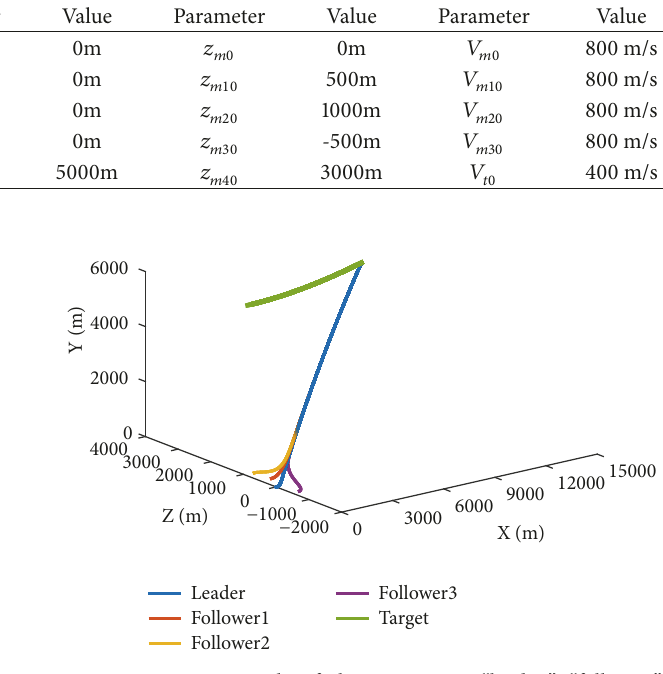
Figure 1: Global communication topology structure of interceptor “leader” and “follower”.